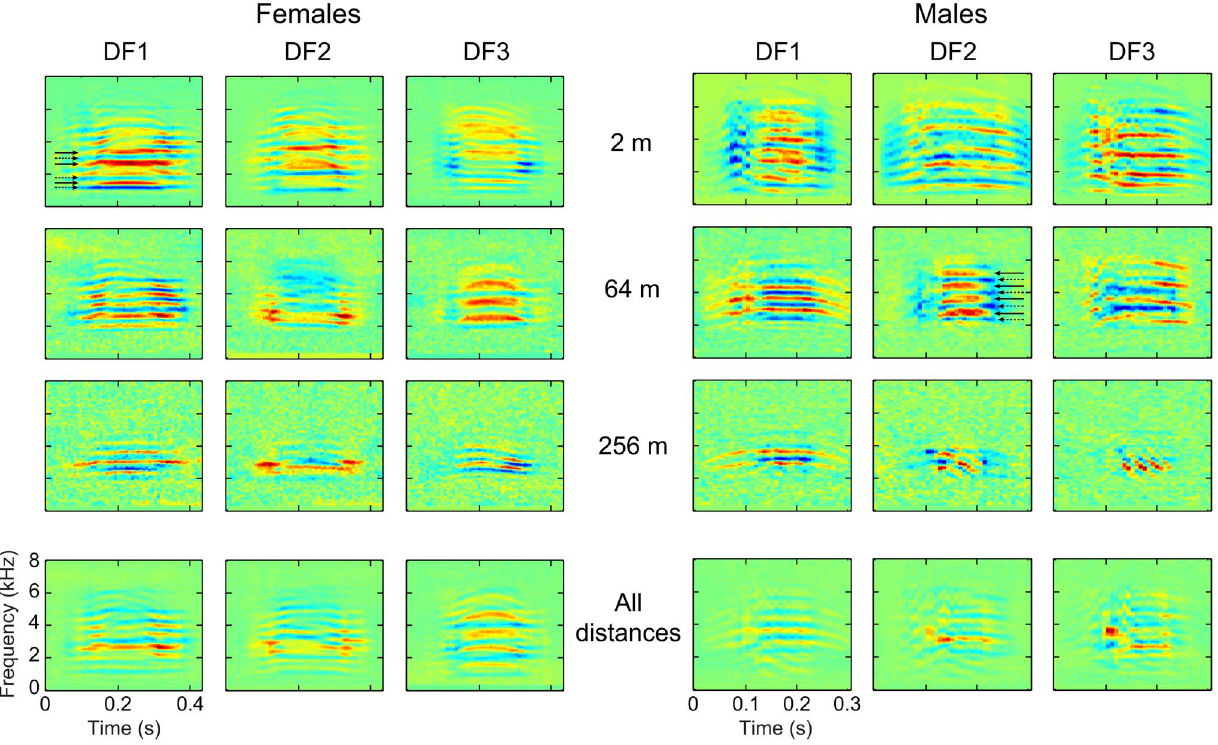
Figure 9. Representation of the discriminant functions (DFs) projected into the spectrographic space for the SPC parameters. The first 3 DFs, obtained from the SPC parameters, are shown for females (left) and males (right). Each row indicates the type of dataset used to perform the DFA: each distance taken separately for 2 m, 64 m and 256 m (first 3 rows) and all distances taken into account (bottom row). As examples, on DF1 at 2 m for females and DF2 at 64 m for males, full arrows show positive frequency bands (red) and dashed arrows show negative bands (blue). This representation enables a description of the most important features in the spectrogram that can be used to discriminate between individuals at various